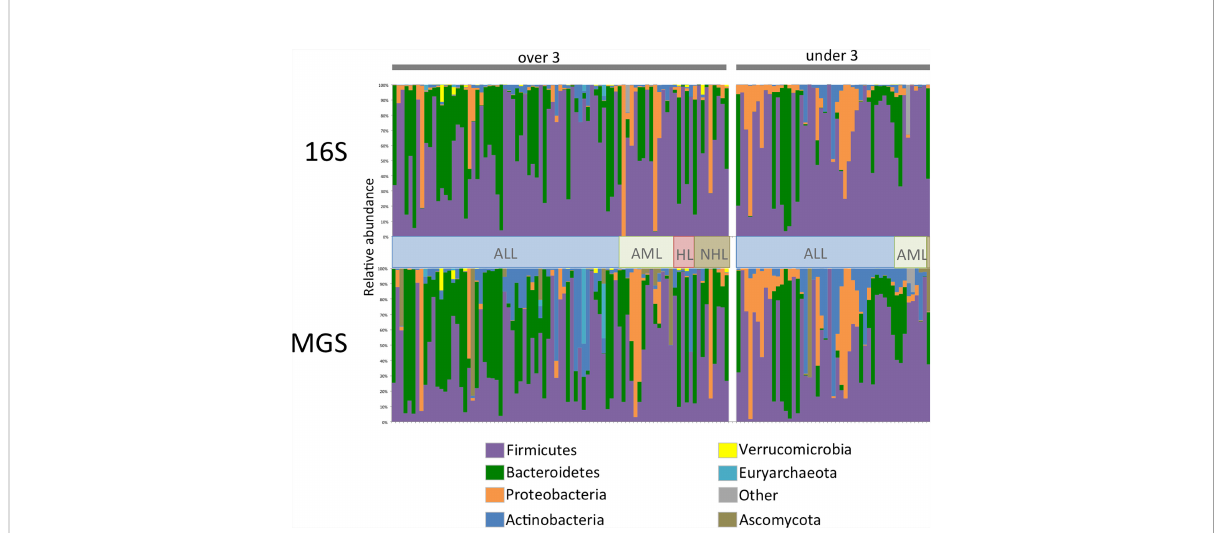
FIGURE 1 Phylum level relative abundance plot for 134 stool samples collected from 47 patients for 16S rRNA (16S) gene and whole shotgun metagenome sequence (MGS) data. Data is separated by age category and cancer type, ALL, acute lymphoblastic leukemia; AML, acute myeloid leukemia;